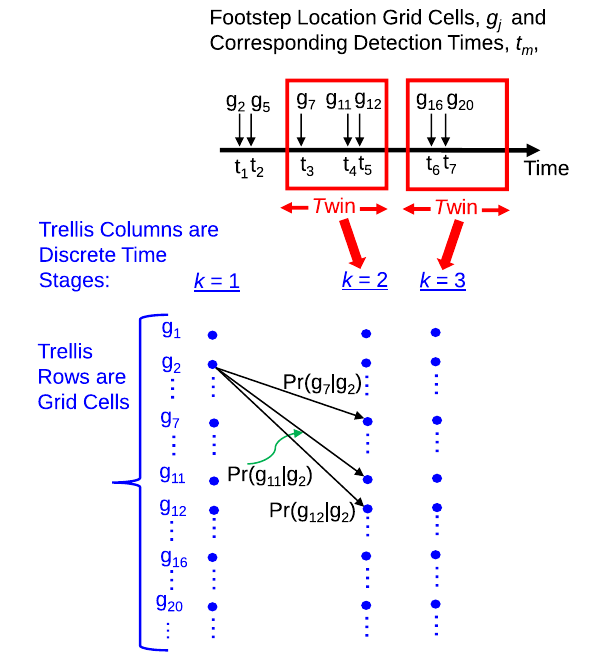
FIGURE 5 | Trellis generation from the example footstep records shown in Figure 3 . Starting from the first footstep at location x 1 (in grid cell g 2 ), the search for stage k = 2 footsteps identifies {( x 3 , g 7 ), ( x 4 , g 11 ), ( x 5 , g 12 )} as being within the required T Win . Each of these stage k = 2 footsteps has a distinct transition likelihood from stage k = 1, denoted Pr ( g j | g 2 ), j = 7, 11,